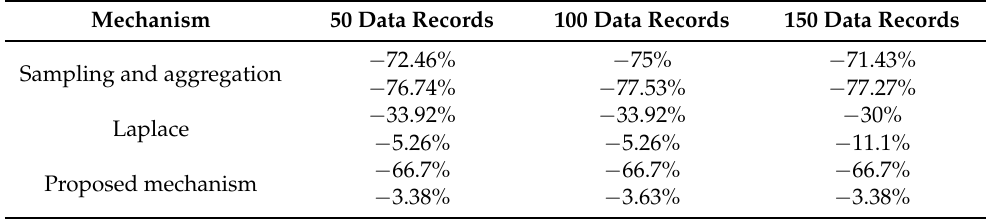
Table 1. RMSE degradation rates corresponding to linear and nonlinear query functions for different data